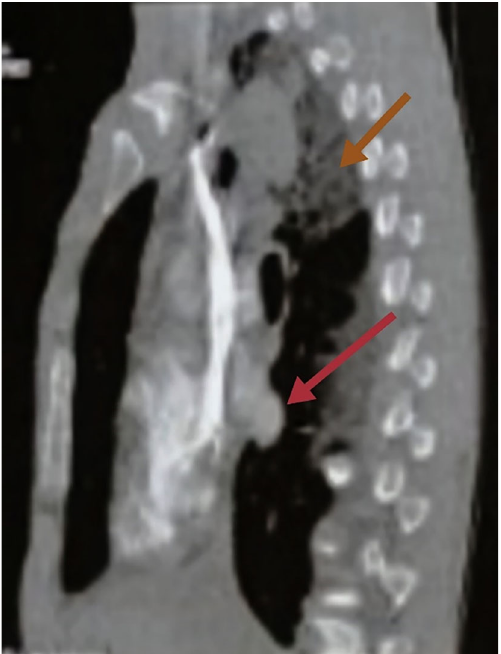
Figure 1. Chest computed tomography scan showed a ground glass opacity in the right upper lobe (brown arrows) associated to a hilar lymphadenopathy with irregular contours (red